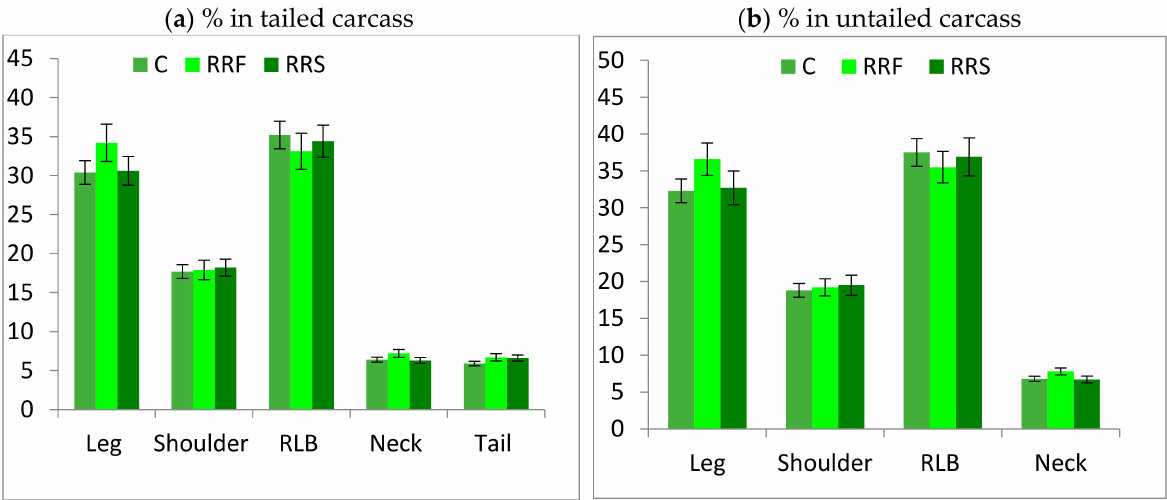
Figure 1. Carcass cut proportions in the tailed and untailed carcasses of Barbarine lambs fed RR-based concentrate.